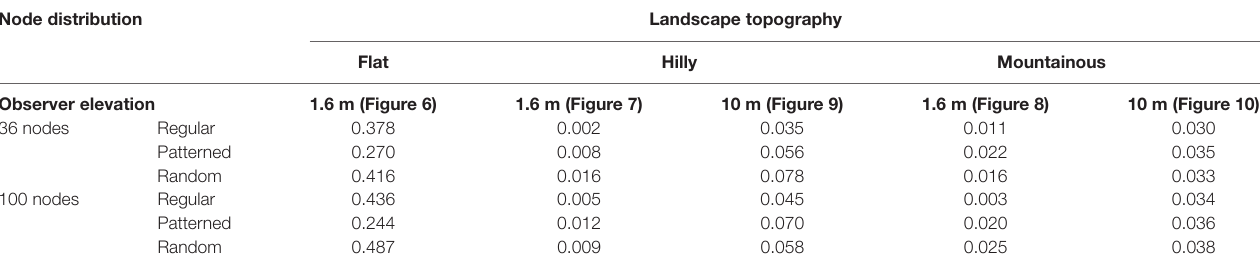
TaBle 4 | Density of example visibility networks shown in Figures 6 – 10 . node distribution